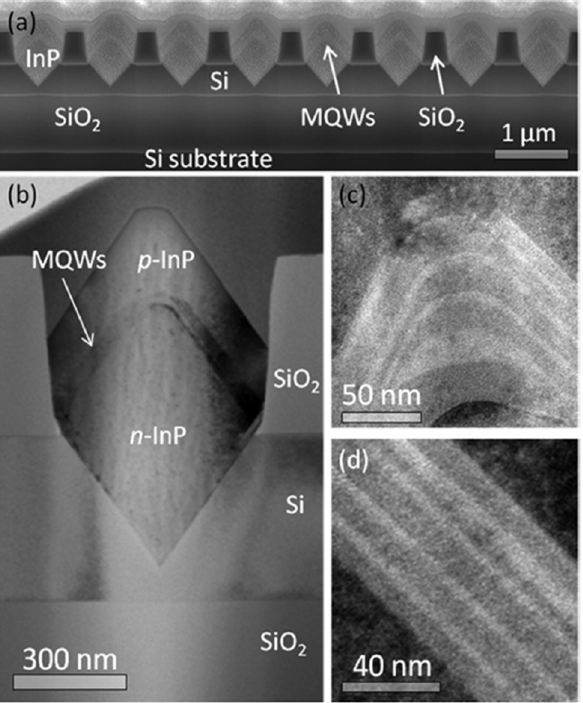
Figure 14. ( a ) SEM cross-section images of the InP nano-ridge. ( b ) TEM image of a single nano-ridge with a good symmetry. TEM images of the QWs and the barrier layers in ( c ) the (001) surface and ( d ) the {11 − 1} B facet. The dark-colored layer is the barrier; the light-colored is the QW. Reprinted with permission from ref. [71] © AIP Publishing. Copyright 2017 Applied Physics Letters.